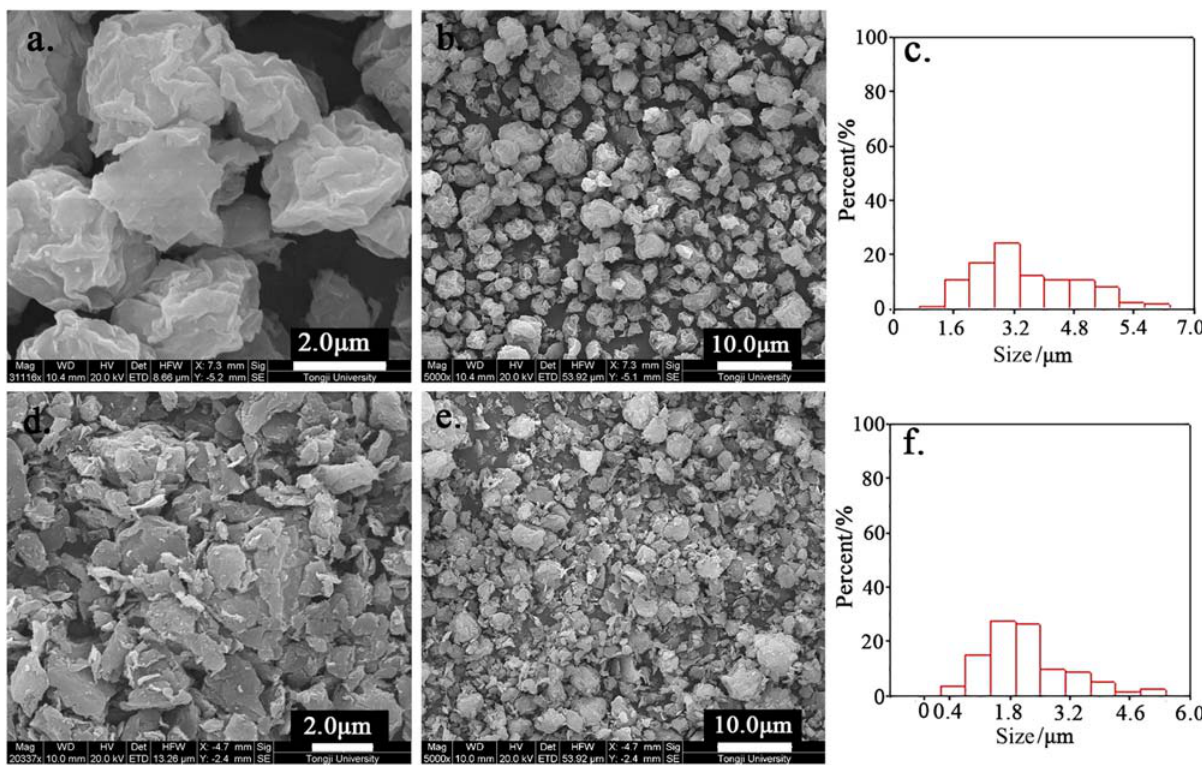
Figure 6: SEM images and size distribution of pristine MMT and APOP - MMT: ( a – c ) pristine MMT, ( d – f ) APOP - MMT.